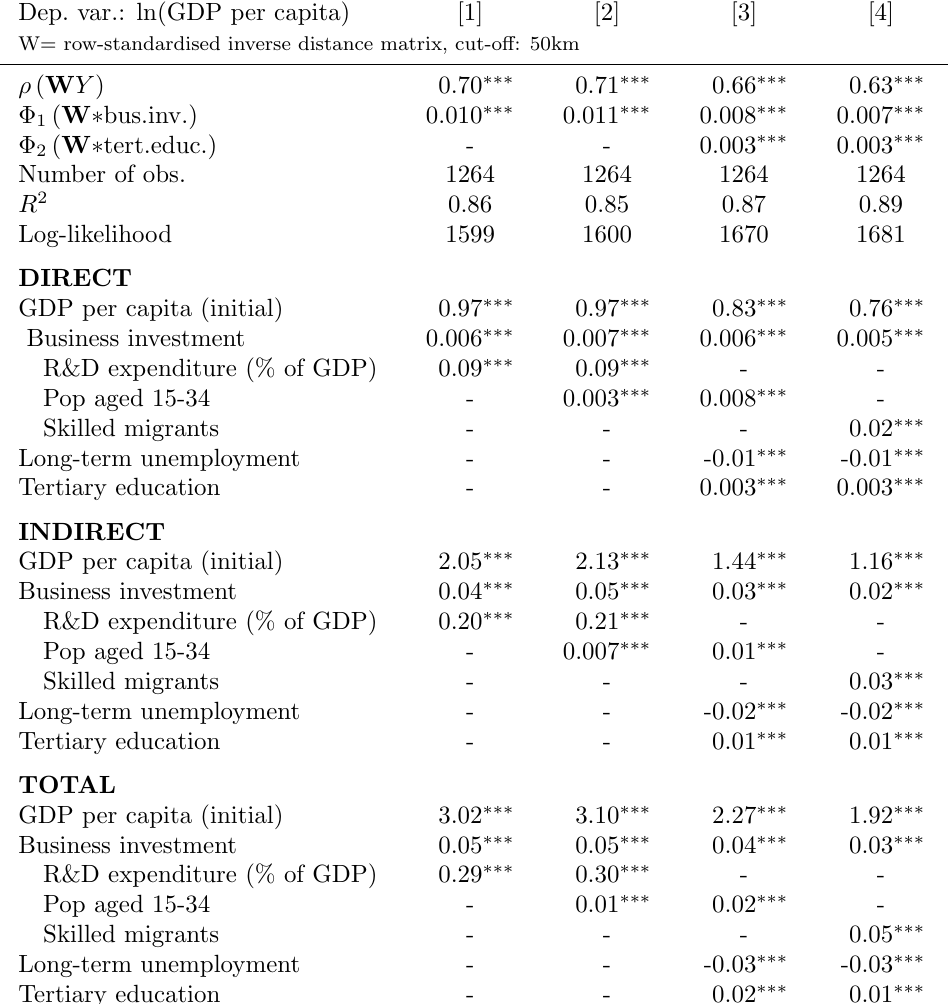
Table 3: Empirical Results – Random effect – Euro area sample Dep. var.: ln(GDP per capita) [1] [2] [3]